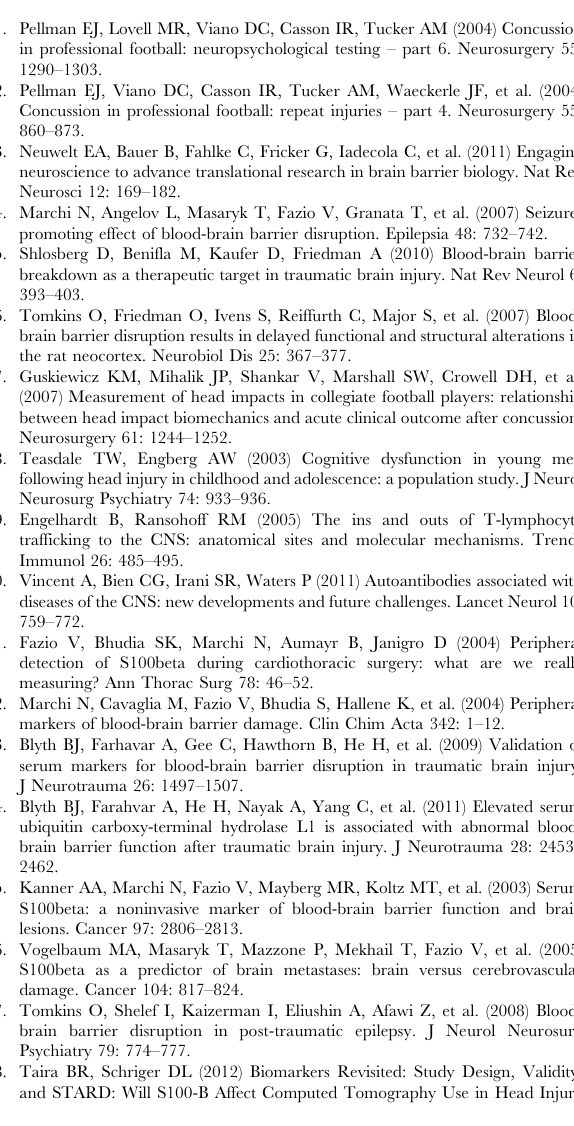
antibodies. ELISA wells were coated with human S100B, 1 m g/ well. Funding: DJ NM JJB. Approval of the final manuscript: DJ. Conceived and designed the experiments: DJ NM JJB. Performed the experiments: VP